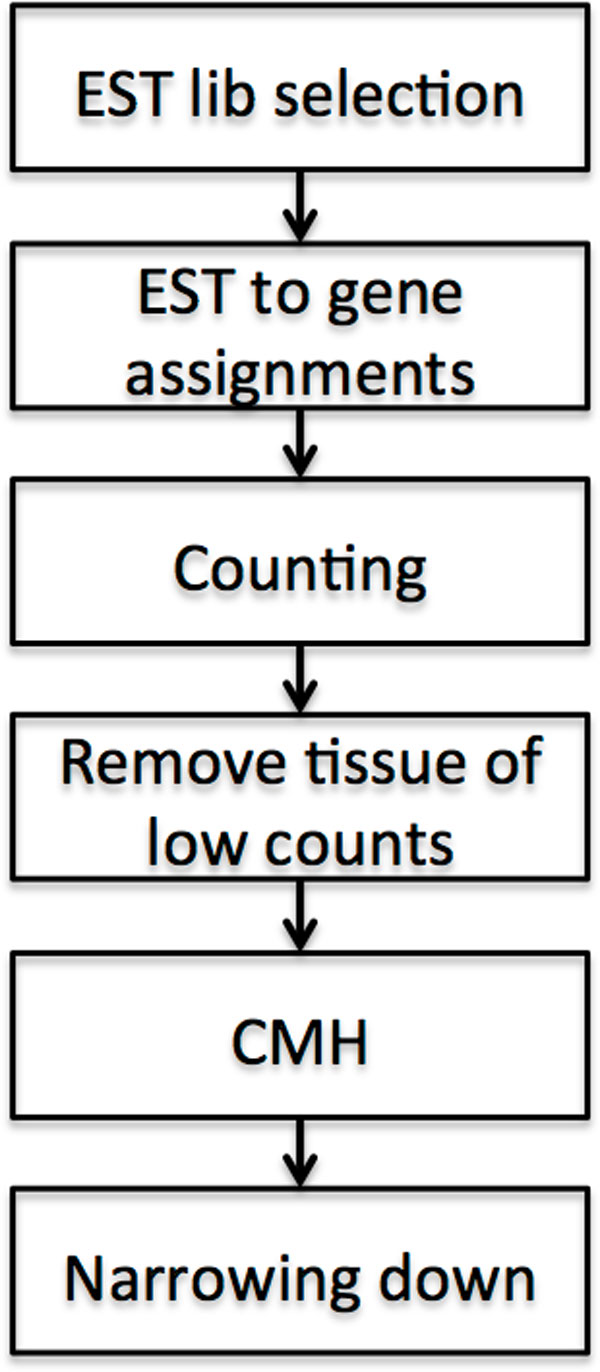
The basic steps in searching for differential expression genes. EST library selection involves selection of suitable EST clone libraries, EST to gene assignment, counting the results, remove tissue categories with low counts, statistical analysis with CMH and the narrow-down of differentially expressed genes (DEGs). The narrow-down procedures includes cross referencing with public microarray data, annotating membrane and secretory proteins, analyzing with String network, and for a few selected genes, validate the expression in different tissues by RT-qPCR.